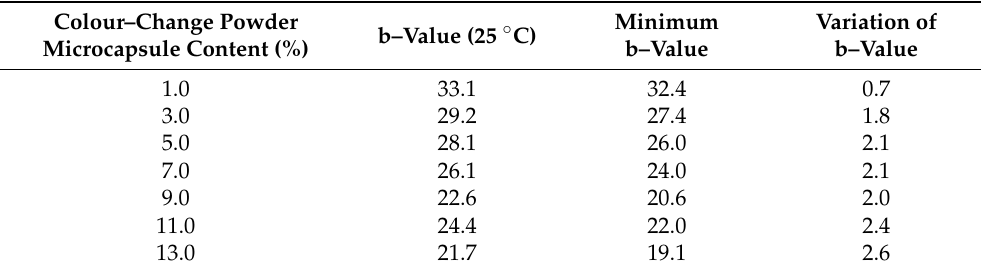
Table 4. Colour difference value of the coating with the core wall ratio 0.033 colour–changing powder microcapsules.